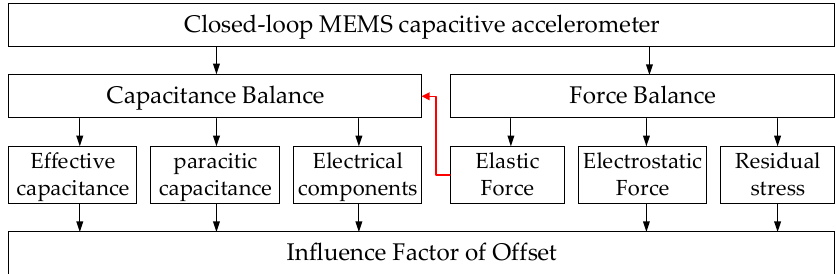
Figure 2. Influence factor of offset in closed-loop MEMS capacitive accelerometer.